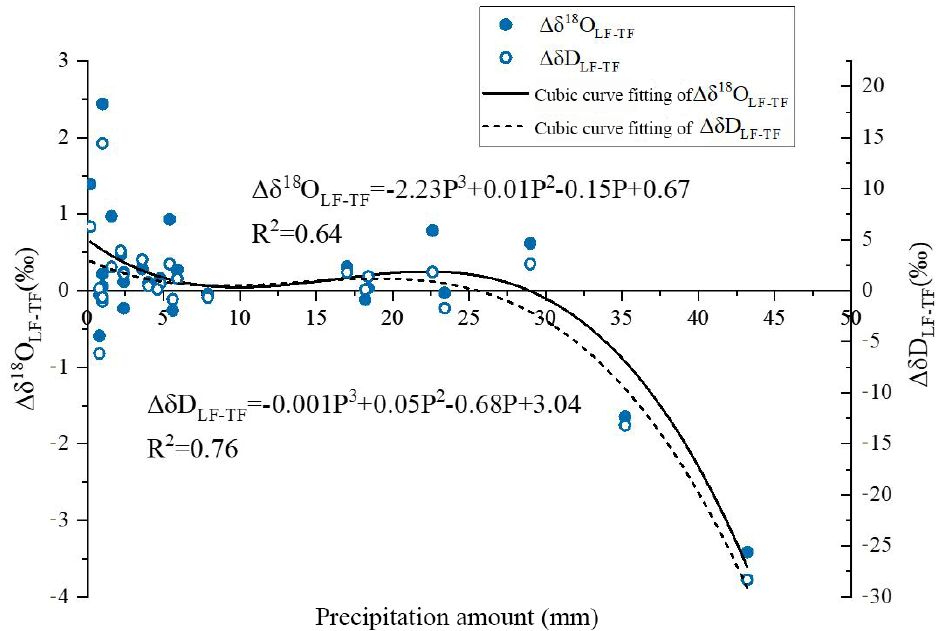
Figure 4. Relationship between isotopic difference between LF and TF ( Δδ 18 O LF-TF and Δδ D LF-TF ) with precipitation.